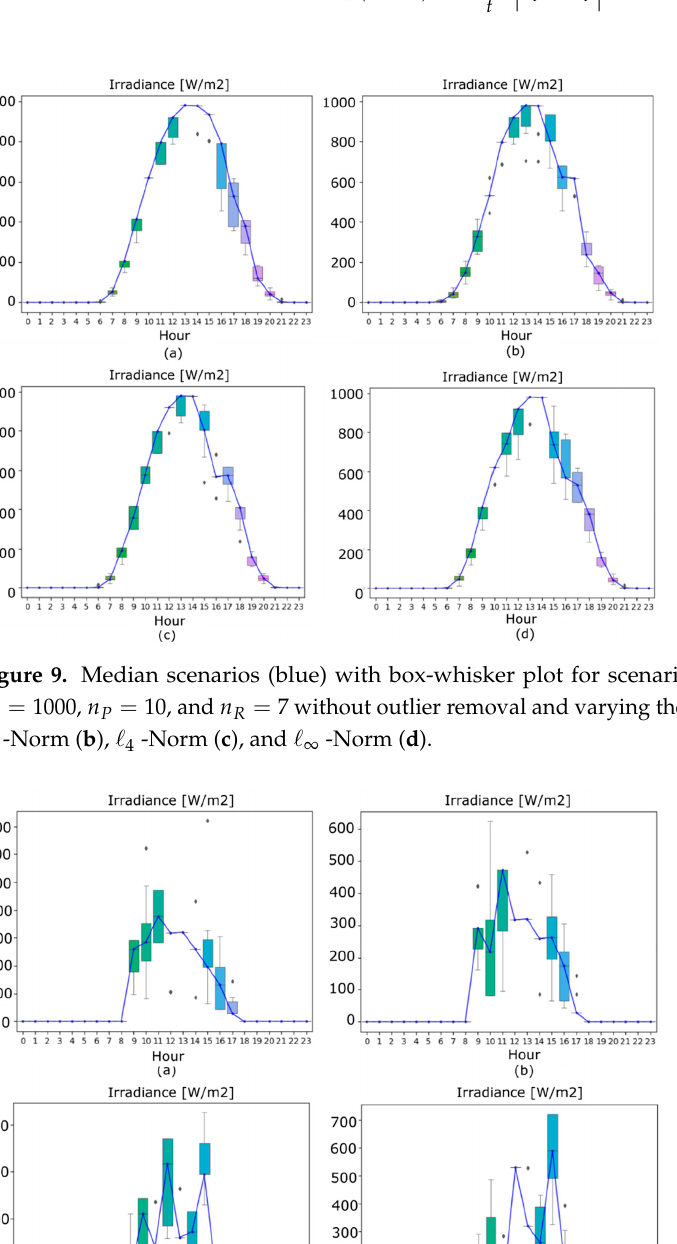
Figure 8. Median scenarios (blue) with box-whisker plot for scenarios generated for January using 𝑛 (cid:3020) = 1000 , 𝑛 (cid:3017) = 10 , and metric = ℓ (cid:2870) -Norm without outlier removal and varying the number of regions ( 𝑛 (cid:3019) ): 3 ( a ), 5 ( b ), 11 ( c ), and 21 ( d ).